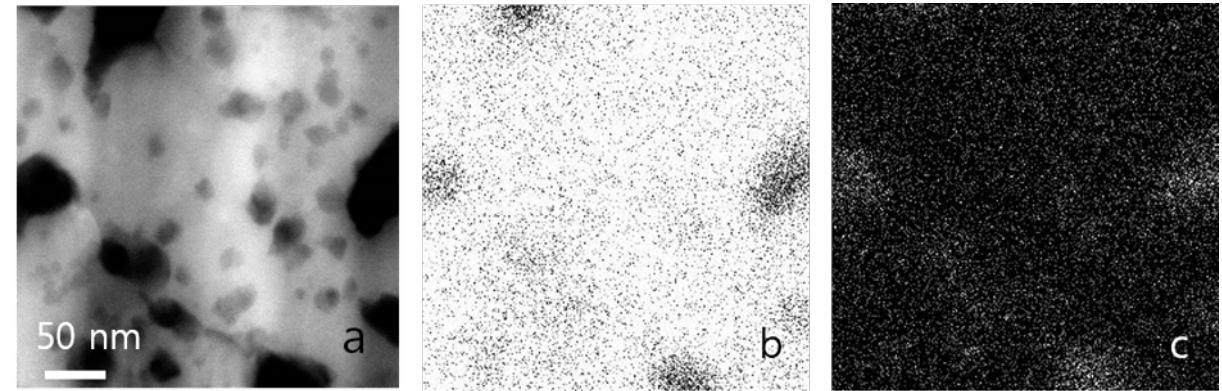
Figure 7: STEM-HAADF image (a) and corresponding STEM-EDS maps for Cu (b) and Cr (c).